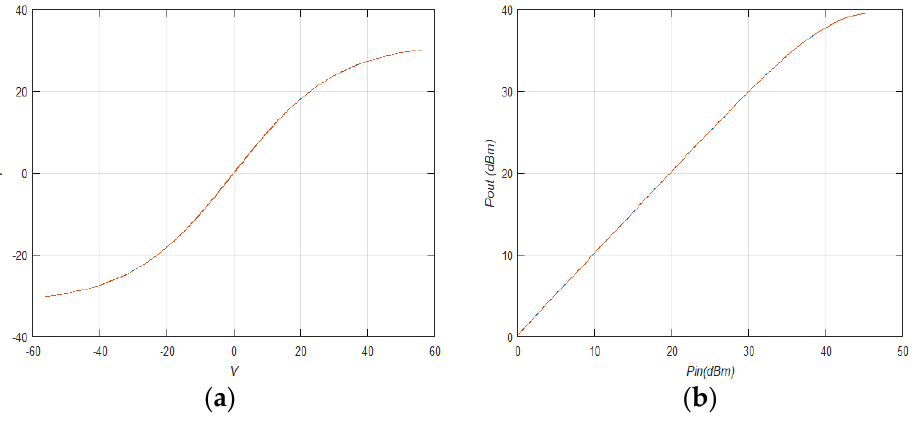
Figure 4. Hyper tangent nonlinear model: ( a ) I/V characteristics; and ( b ) Pin/Pout characteristics. The input signal to the model was generated in Matlab and is based on the specifica- tions of the Orthogonal Frequency Division Multiplexed (OFDM) signals that resemble LTE signals as shown in Table 3 [16]. The periodogram of the output of the passive nonlinearity in (10) was computed for an input that consists of two simulated OFDM signals with 20 MHz bandwidth each and a frequency separation of 100 MHz. The periodogram was estimated using different window functions. Note that, in order for the periodogram of the output of the nonlinearity to show the IMD components, the sampling frequency needs to be greater than the highest IMD component. For example, in order to show the 9th intermodulation component, the sampling frequency must be greater than 9 ω 0 . Table 3. OFDM Signal Parameters.